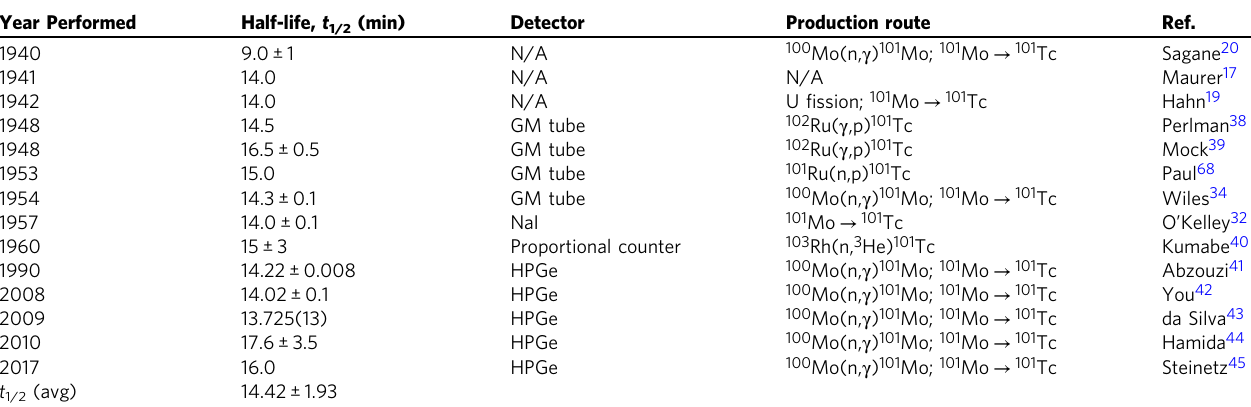
Table 1 Experimentally measured values for the t 1/2 of 101 Tc for given production routes using different detectors. Year Performed